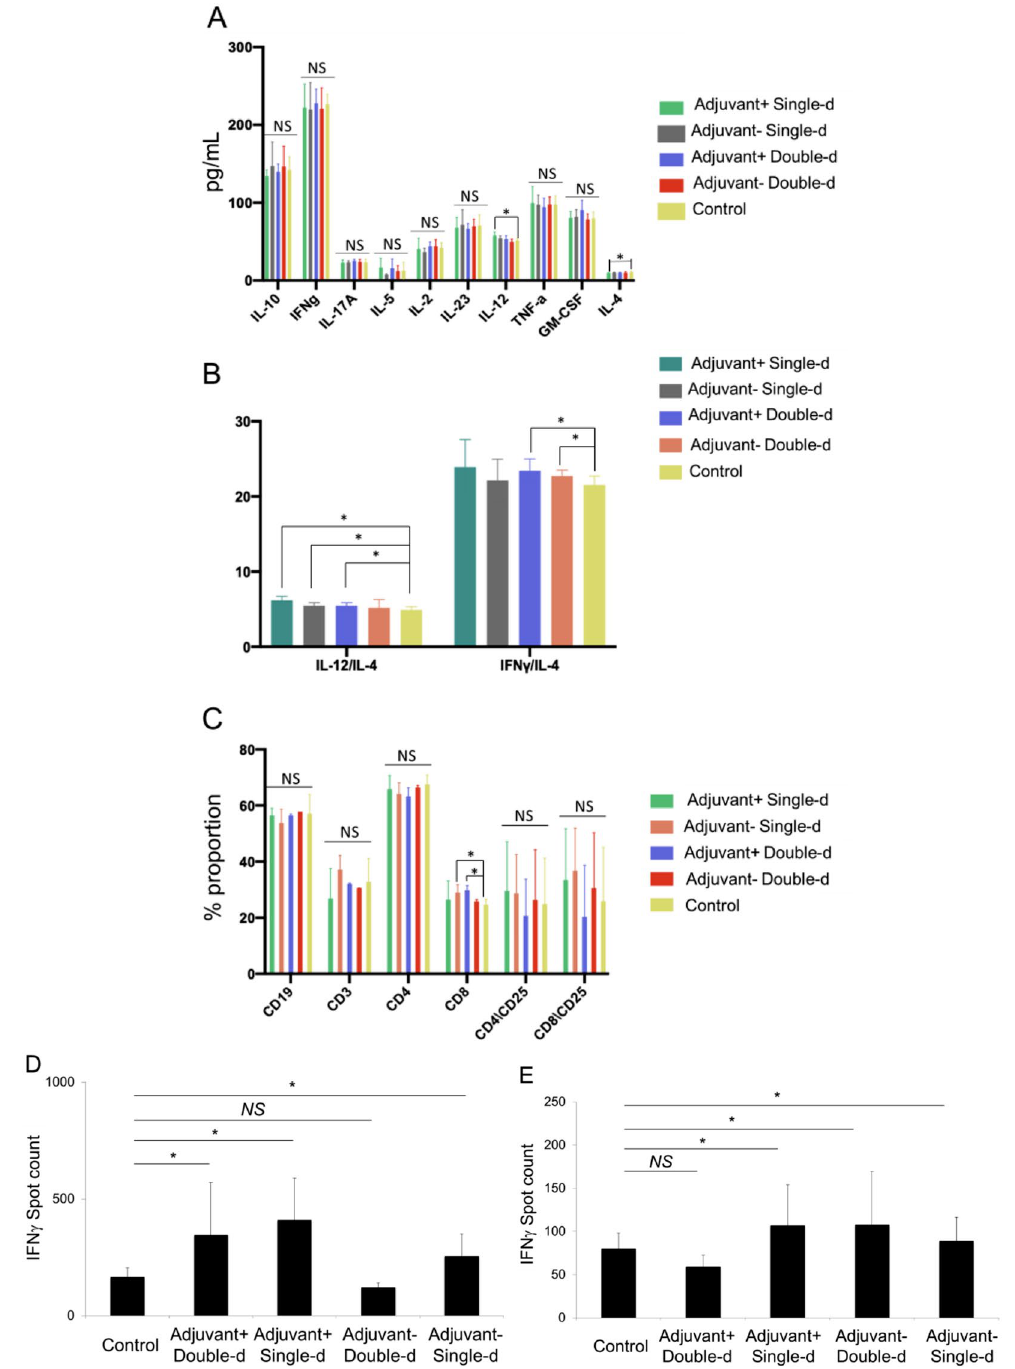
Figure 8. Mouse spleen T cell response upon SARS-CoV-2 antigen. ( A ) Bar graphs showing quantitated mouse Th1, Th2, and Th17 specific cytokines (picogram/ml) secreted by the T cells isolated from dissected spleens on day 34 re-stimulated with SARS-CoV-2 specific S, N, and M-protein peptide pool. ( B ) Bar graphs showing the balance of Th1 and Th2 CD4 T cell response. The ratio of IL-12 to IL-4 or IFNg to IL-4 demonstrates Th1– dominant response. ( C ) Bar graph showing a change in the proportion of immune cell subtypes re-stimulated with the peptide pool (B cell, CD19 + ; T cell, CD3 + ; T helper cell, CD3 + CD4 + and cytotoxic T cell, CD3 + CD8 +). The activation marker of T cells is the upregulation of CD25. ( D ) Bar graph showing IFNγ spots formed during mouse spleen T cells isolated on day 21 incubated with whole inactive SARS-CoV-2 virus for 72 h. ( E ) Bar graph showing IFNγ spots formed during mouse spleen T cells isolated on day 34 incubated with SARS-CoV-2 specific S, N, and M-protein peptide pool for 72